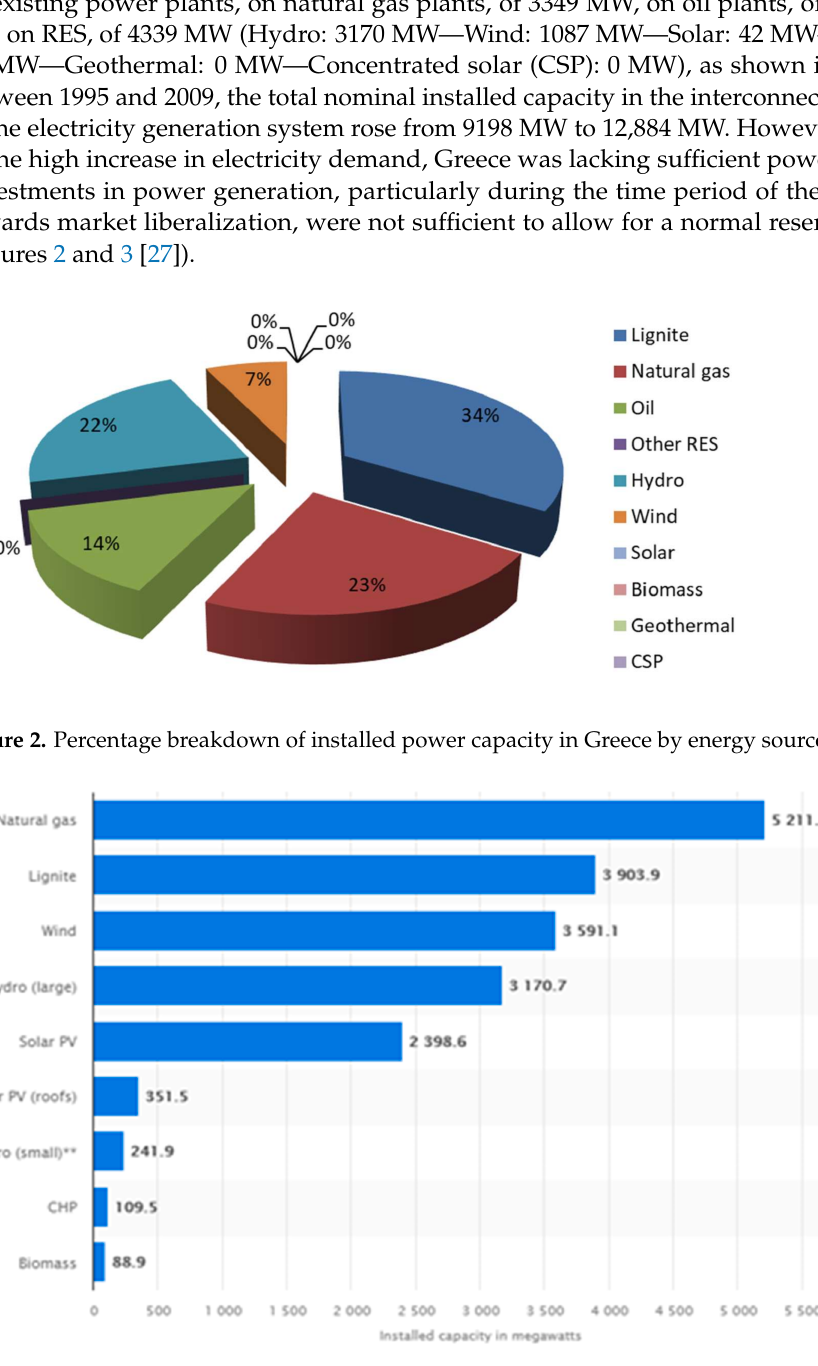
Figure 3. Sources of large scale energy capacity (MW) installed in Greece, as of June 2020